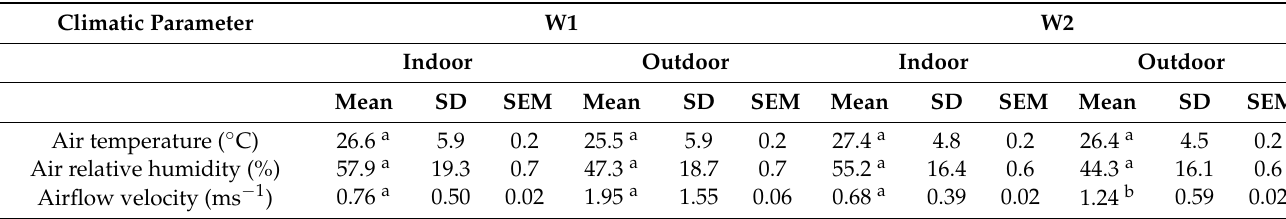
Table 2. Statistical measures for indoor and outdoor climatic parameters in W1 and W2, and pairwise comparison for each parameter between the two weeks. Groups of values that do not share a letter (a, b) are significantly different within each row. W1